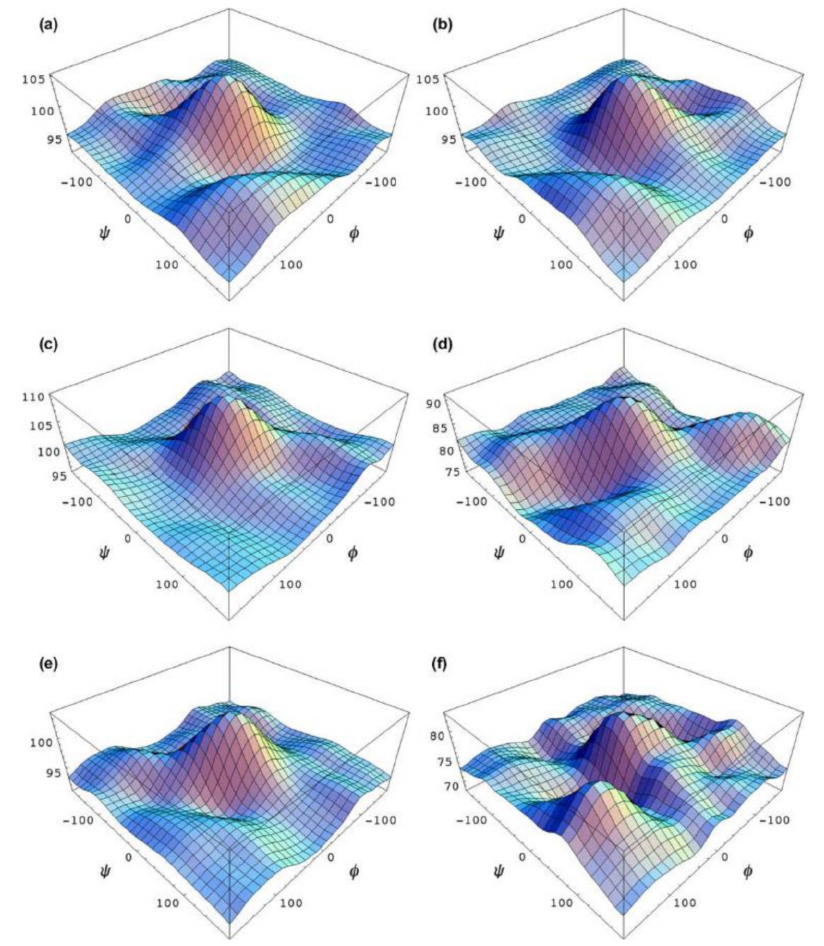
Figure 43. 13 C-NMR chemical shift surfaces for the pairs of transglycosidic carbons in α -(1 → 1 (cid:48) ), β -(1 → 4 (cid:48) ), and α -(1 → 4 (cid:48) )-linked D-Glcp disaccharides as a function of the glycosidic bond dihedrals. Corresponding surfaces are marked accordingly as ( a – f ). Reproduced from Sergeyev and Moyna [153] with the permission of